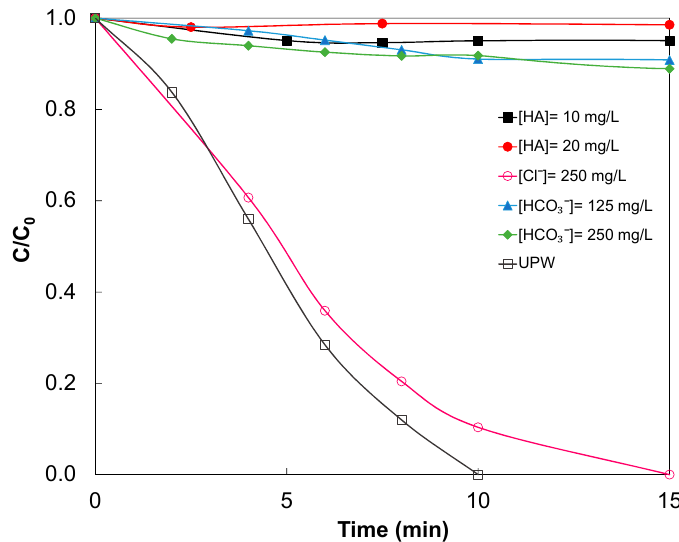
Figure 7. E ff ect of organic matter and inorganic anions at various concentrations, on SMX degradation. Figure 7. Effect of organic matter and inorganic anions at various concentrations, on SMX Experimental conditions: C SMX = 500 µ g / L; C LNO = 250 mg / L; C SPS = 100 mg / L; room degradation. Experimental conditions: C SMX = 500 μ g/L; C LNO = 250 mg/L; C SPS = 100 mg/L; room temperature.